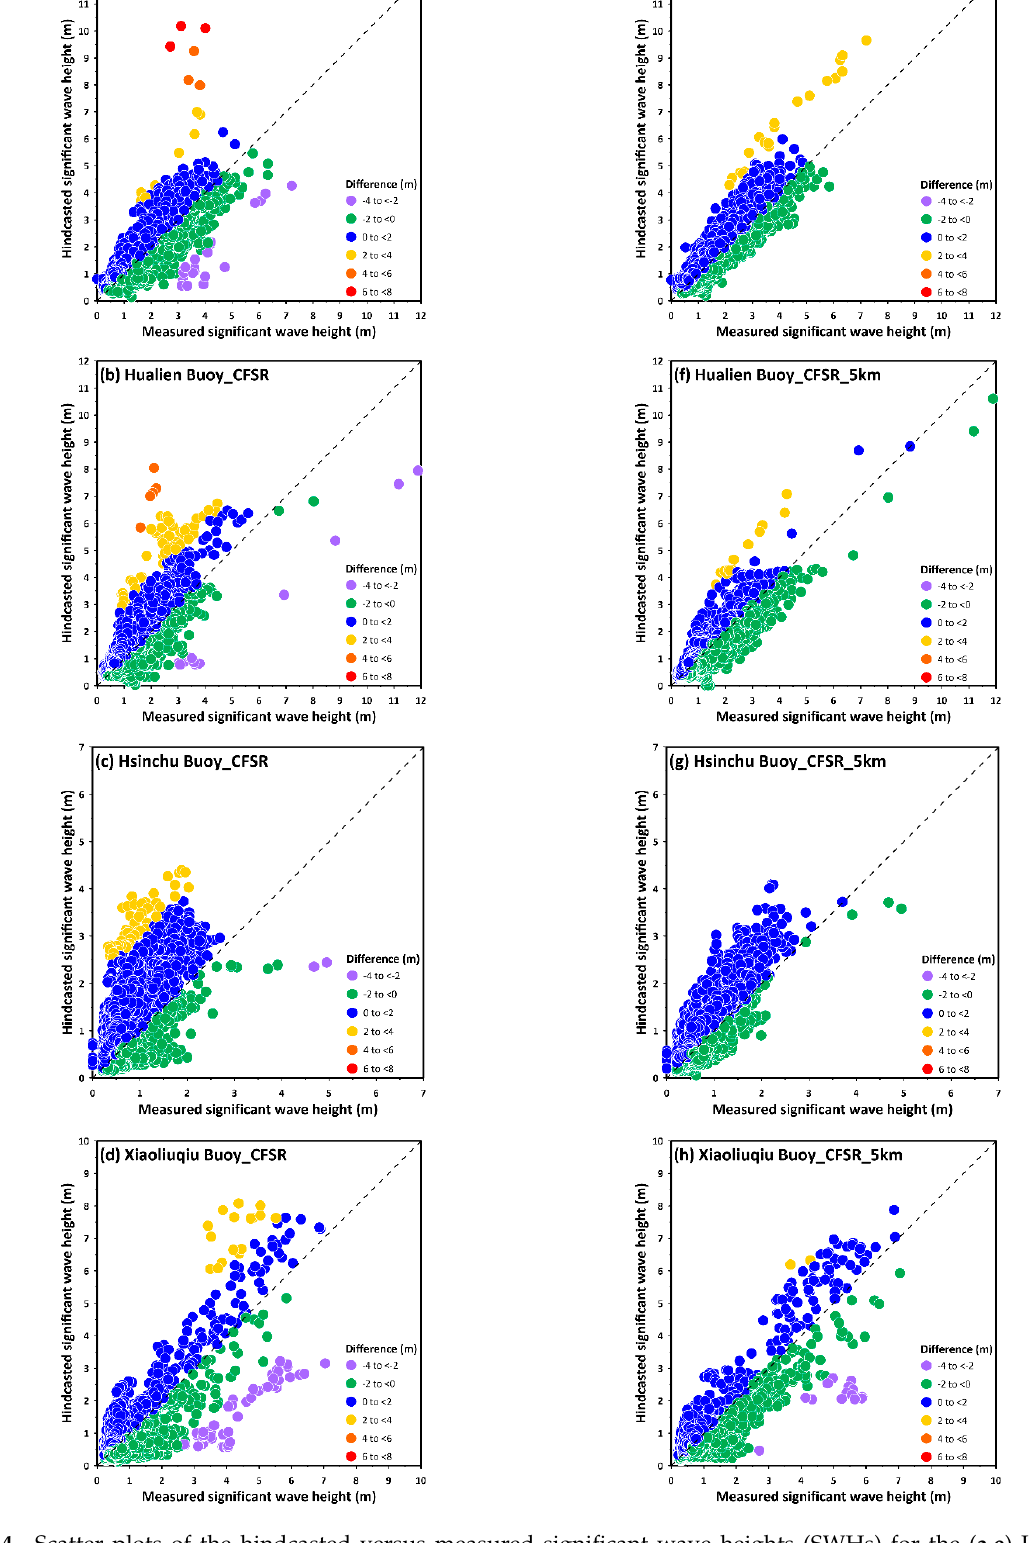
Figure 4. Scatter plots of the hindcasted versus measured significant wave heights (SWHs) for the ( a , e ) Longdong, ( b , f ) Hualien, ( c , g ) Hsinchu and ( d , h ) Xiaoliuqiu buoys using the ( a – d ) Climate Forecast System Reanalysis (CFSR) and ( e – h ) CFSR_5km winds.